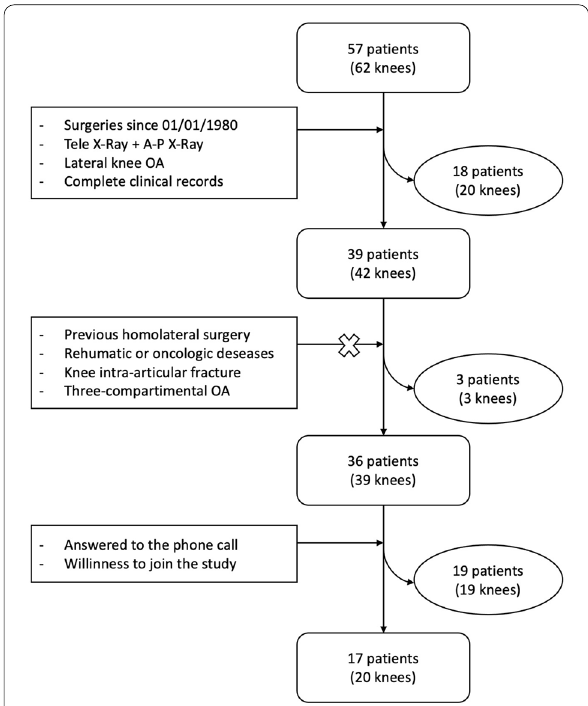
Fig. 2 Flow chart of patient selection, from the initial group to the final subjects analyzed. Inclusion and exclusion criteria are shown in square boxes . The patients eliminated in each step are shown in the oval